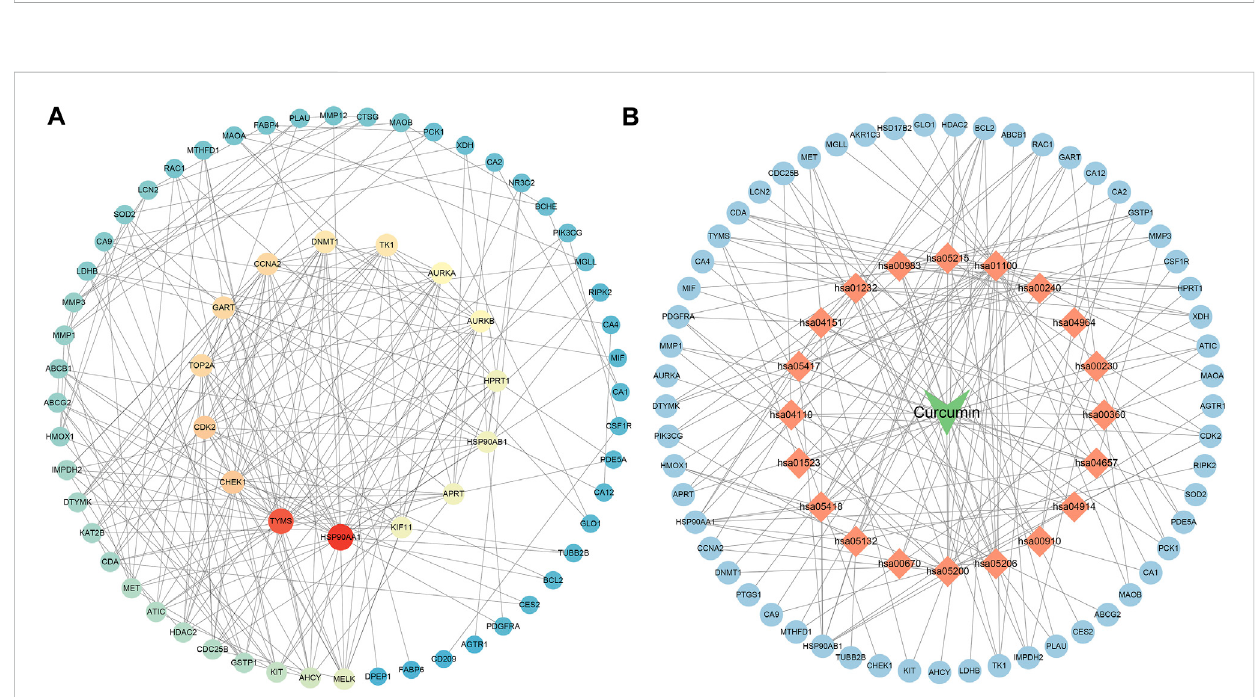
FIGURE 2 Targetsrelevanttothetreatmentofcoloncancer. ( (A) .VolcanoplotofDEGsassociatedwithcoloncancer. (B) .Venndiagramshowingthecommon part of curcumin and colon cancer).